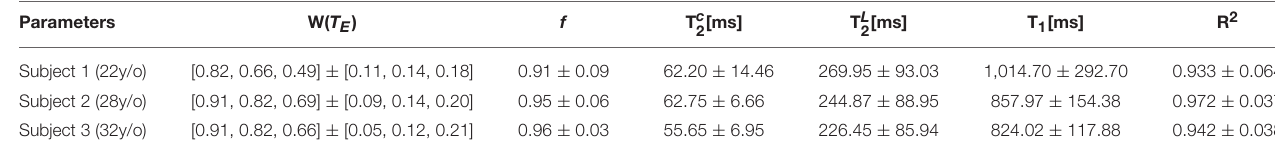
b 0 , demonstrating the = (cid:12) (cid:12) S across all volunteers. b 0 = (cid:12) (cid:10) (cid:11) (cid:12) b 0 . = (cid:12) (cid:12)